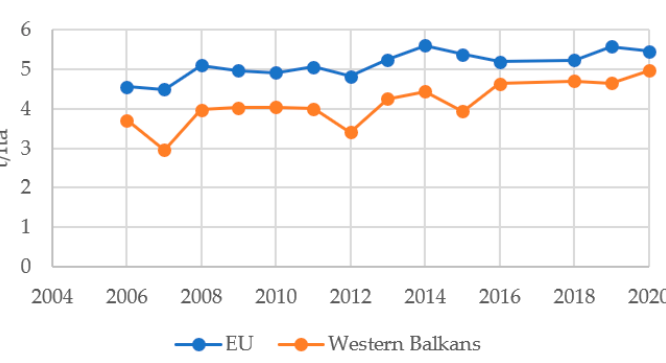
basis of data from the World Bank